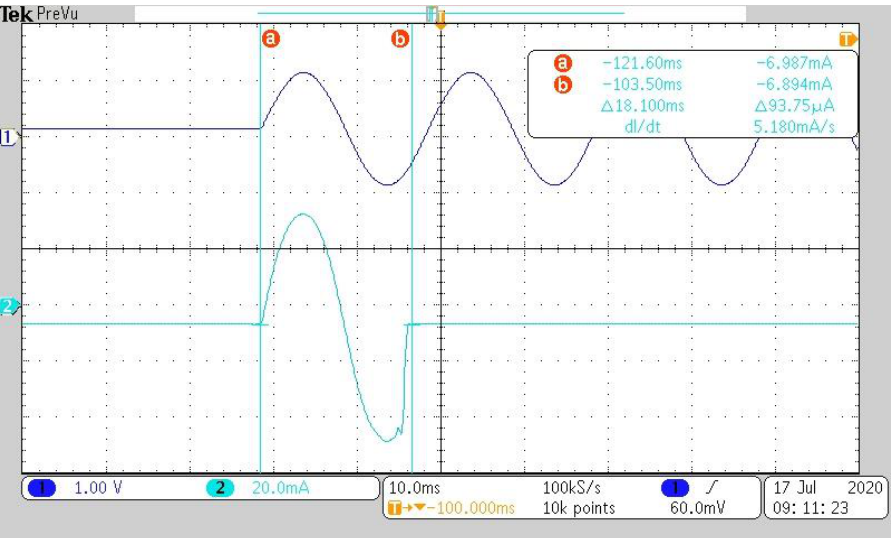
Figure 13. Supply voltage (channel 1) and disconnection current (channel 2) vs. time for RCD-1, with an input of 30 mA (50 Hz), initial phase of 0°, and measured break time of 18 ms.